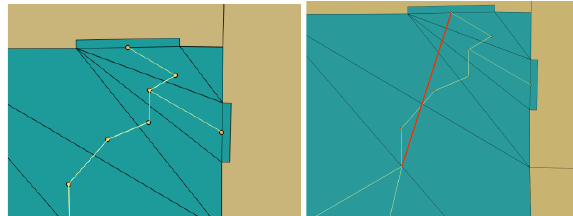
Figure 8. Serpentine routes in proximity of corners and path